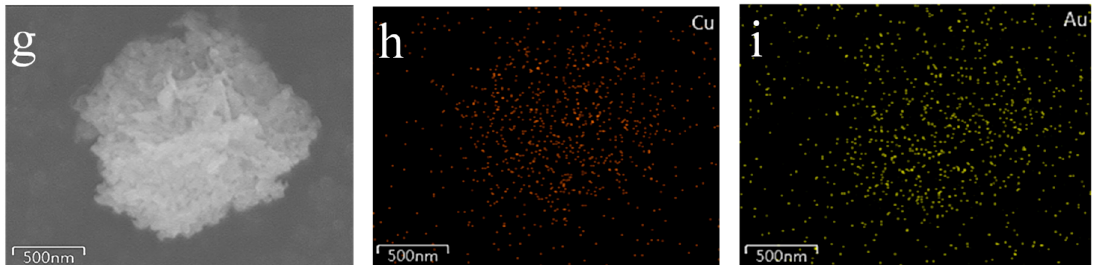
Figure 2. SEM images of Bi 2 WO 6 ( a ) and Bi 2 WO 6 ‐ 400 ( b ) SEM images and mapping of the Au/Bi 2 WO 6 ‐ 400 (calcinated at 300 °C): Au 1.30 wt % ( c , d ); CuO/Bi 2 WO 6 ‐ 400: Cu 5.10 wt % ( e , f ) and Au – CuO/Bi 2 WO 6 ‐ 400: Cu 4.85 wt %, Au 0.438 wt % ( g – i ).